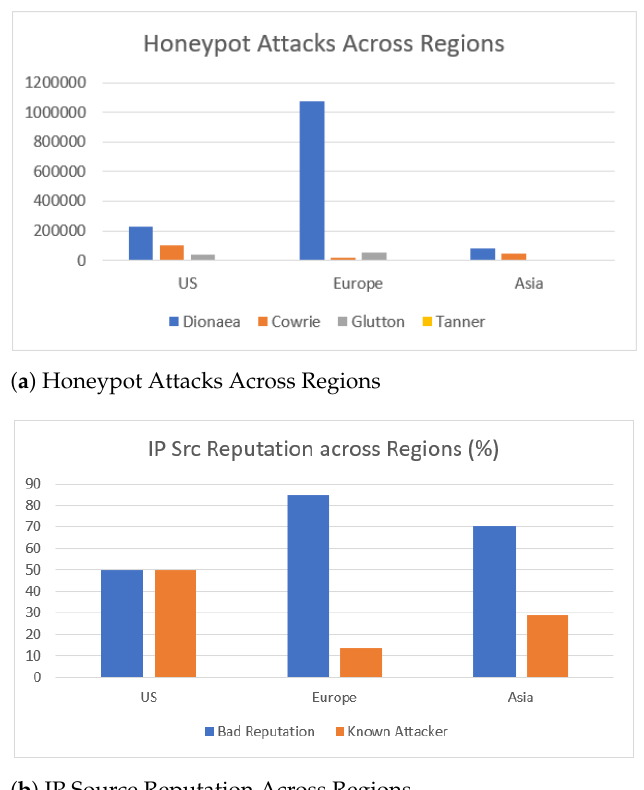
Figure 16. Honeypot Attacks and IP Source Reputation Across